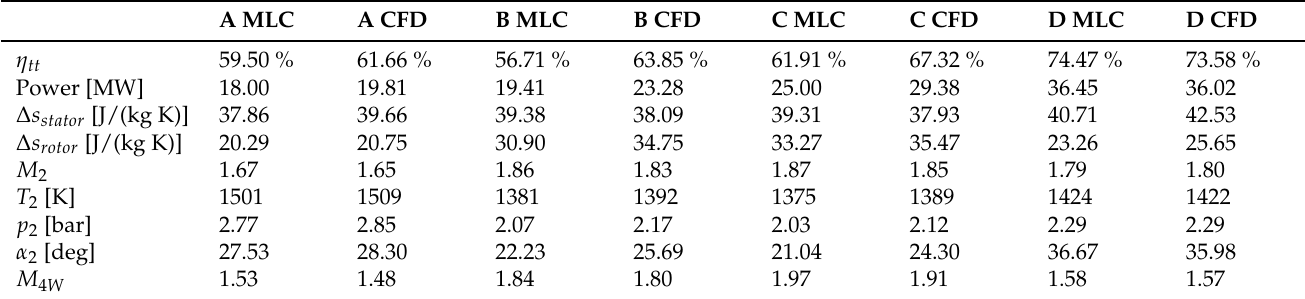
Table 3. Detailed quantitative comparison between the results of the 3D coupled stator-rotor simula- tions and the mean-line code